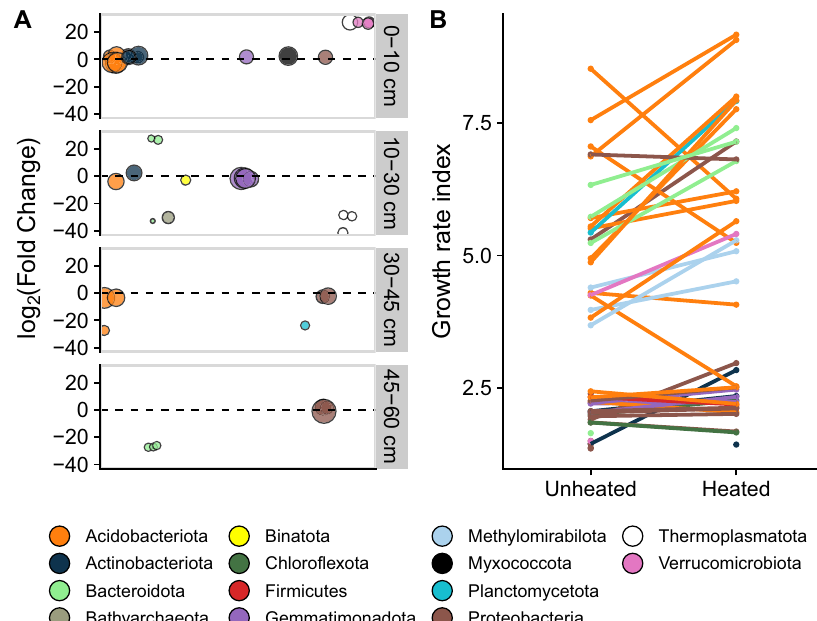
Fig. 6 Change in abundance and growth rate of metagenome-assembled genomes (MAGs) with soil heating. MAGs with signi fi cant changes in abundance by soil heating (Wald test: p < 0.050) are shown by phylum and across depths ( A ; note no signi fi cantly different MAGs were found in the 60 – 80 cm soil depth). Points denote individual MAGs and sizes represent the average relative abundance of the MAG in the unheated plots. The average growth rate index across all depths is plotted for each MAG shown by phylum ( B